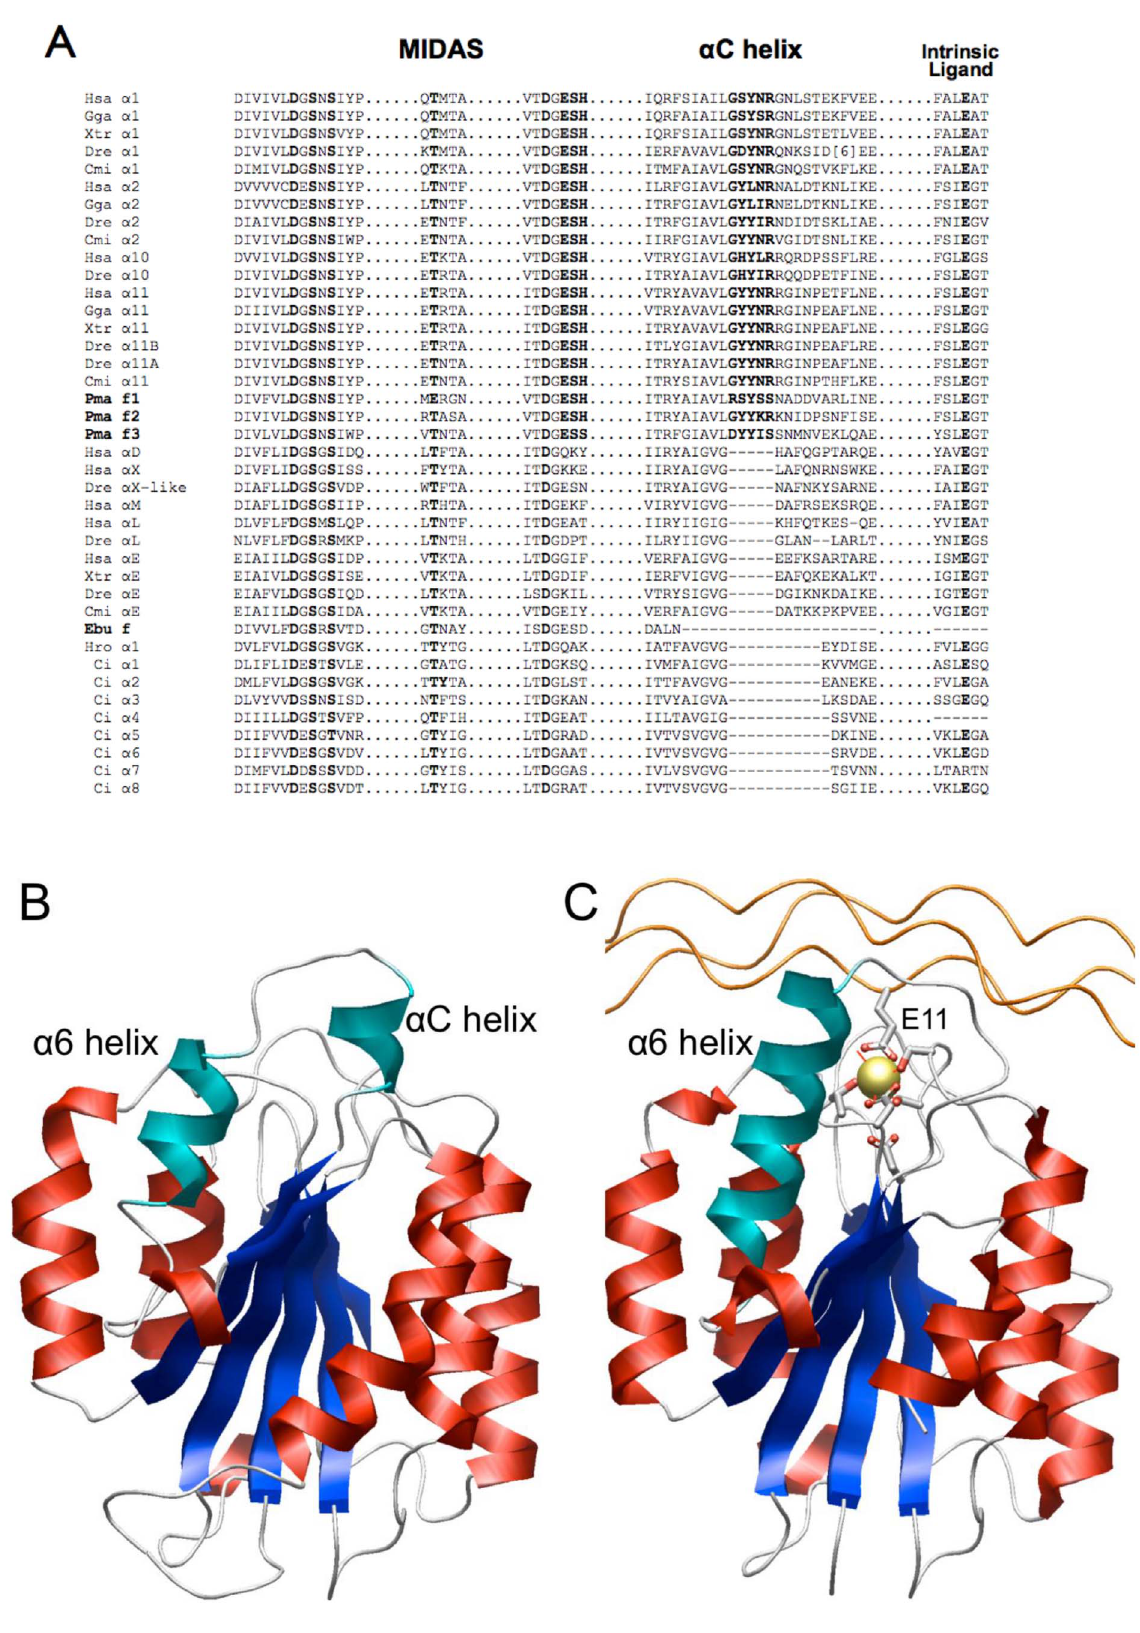
Figure 2. Key features of the integrin a I domain. (A) Alignment of representative sequences, including the three sea lamprey fragments, one short EST fragment derived from the inshore hagfish genome, and four sequences from the elephant shark genome (highlighted in bold). The residues DxSxS…D…T of MIDAS (in bold) function to bind directly or via water molecules to the metal ion where natural ligands bind via a glutamate